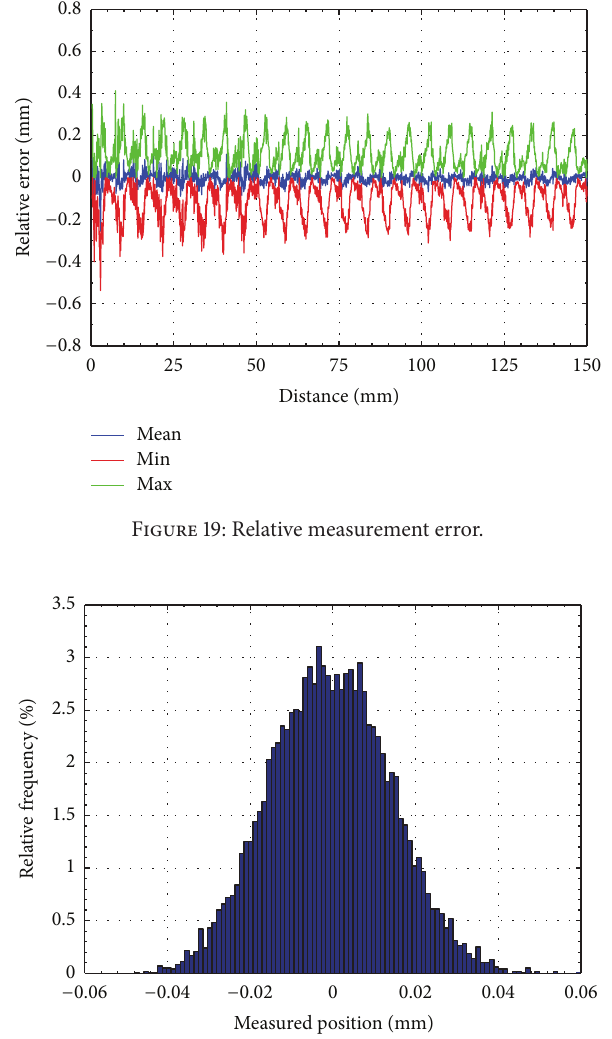
Figure 20: Standard deviation of measurement